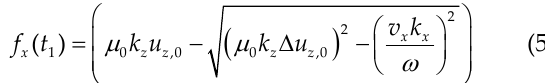
t and after t ), the 1 2